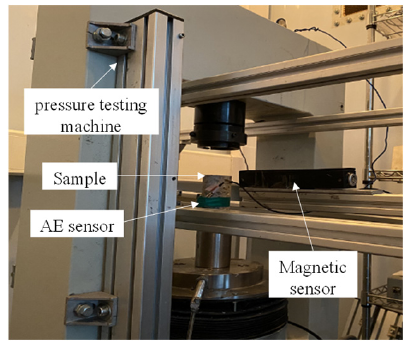
Figure 2. Experimental setup photo.